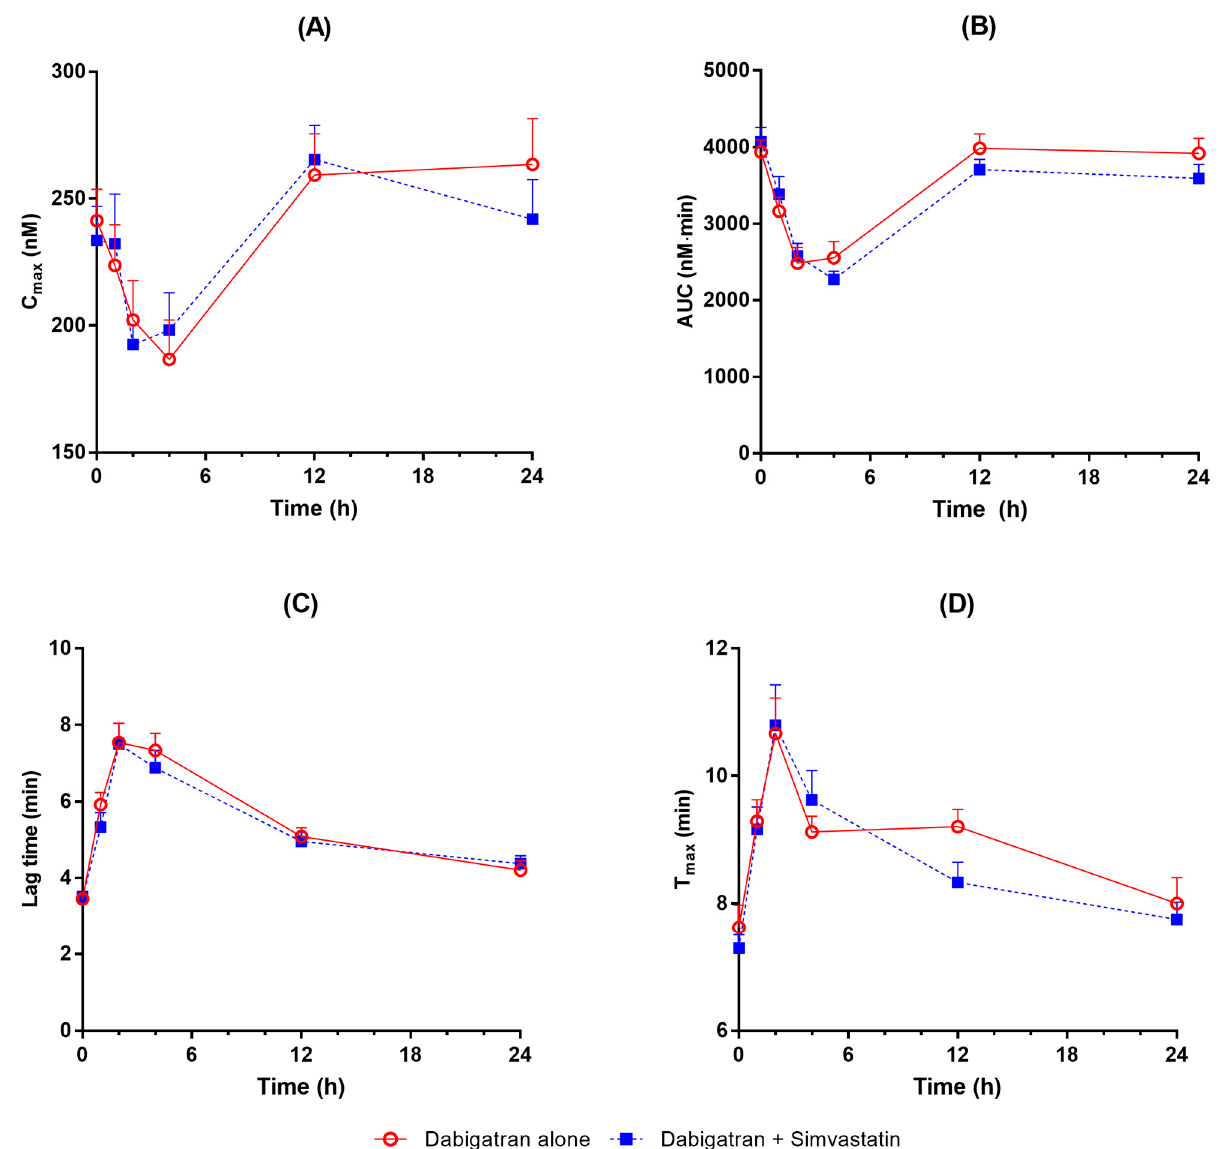
Figure 3. Thrombin generation assay profiles after administration of dabigatran alone and co-administration with simvastatin (( A ) Peak thrombin concentration (C max ), ( B ) endogenous thrombin potential (AUC), ( C ) lag time, and ( D ) time to C max (T max )).